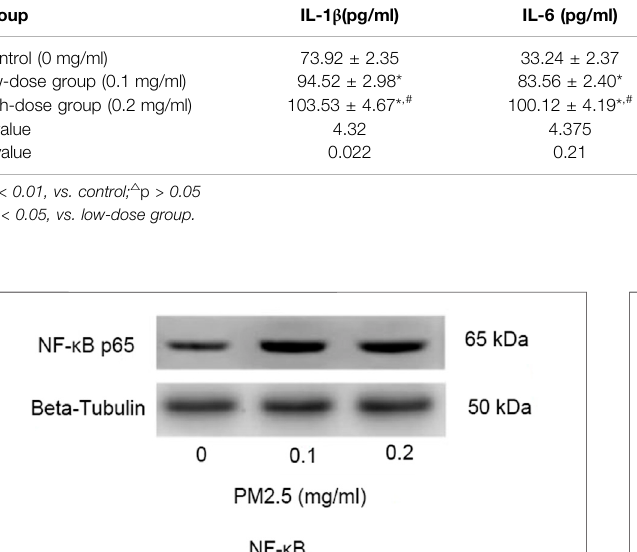
TABLE 2 | The expression levels of IL-1 β ,IL-6,TNF- α ,NF- κ B p65, Cx43 in mouse bone marrow ( ‾ x ± s ). Group